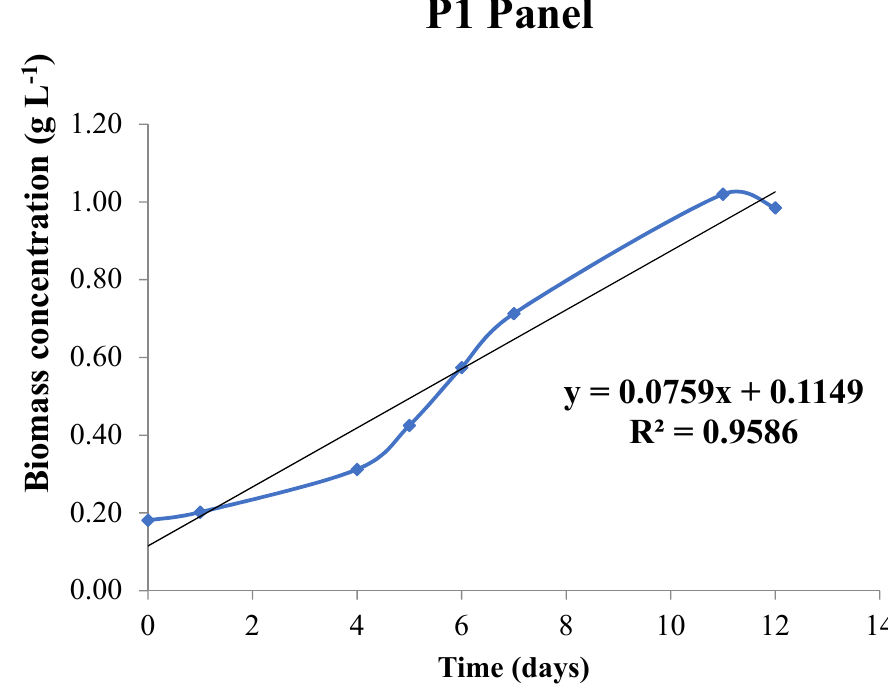
Figure 9. Growth curve of “La Orden” species with fertilizer medium in panel photobioreactor of the pilot plant.